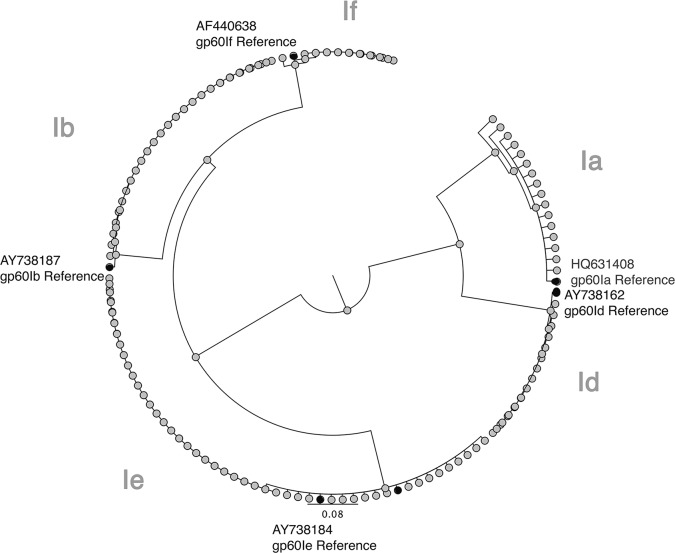
Phylogenetic Relationship of 101 Cryptosporidium parasites isolated in Bangladesh to each other (open circle) and to the reference sequences (closed circle) gp60Ia (HQ631408), gp60Ib (AY738187), gp60Id (AY738192), gp60Ie (AY738184), gp60If (AF440638).Neighbor-Joining consensus tree was drawn using the Geneious program (R7). Any apparent diversity is due to ambiguous bases.